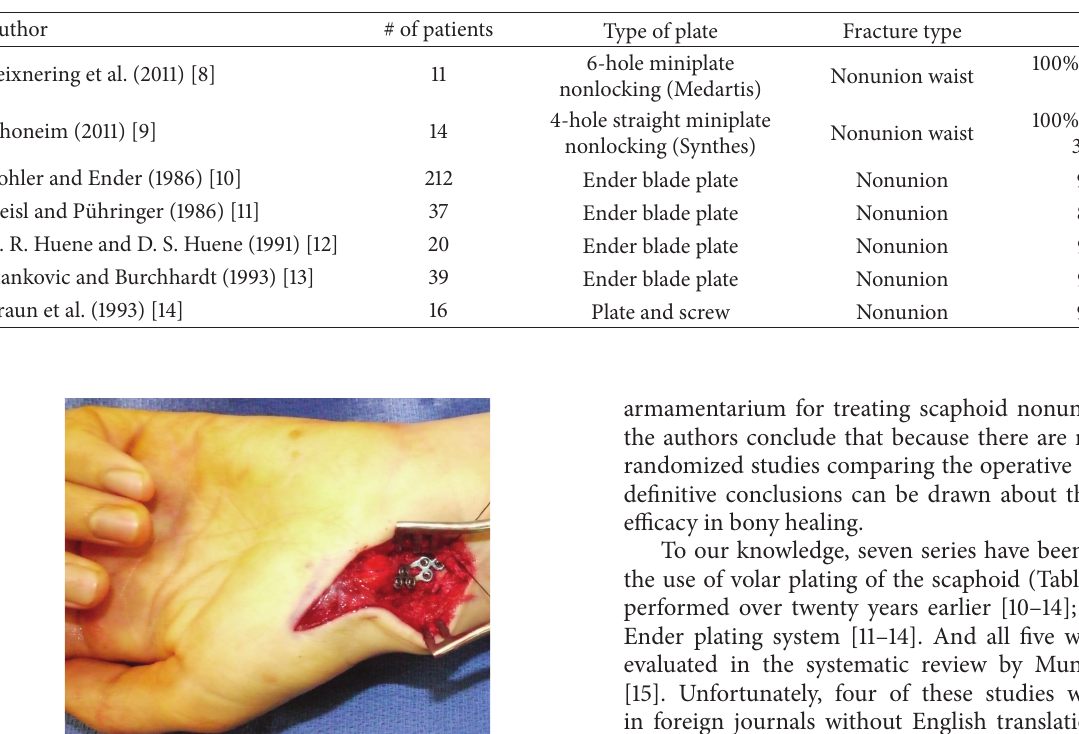
Table 1: Published case series on scaphoid